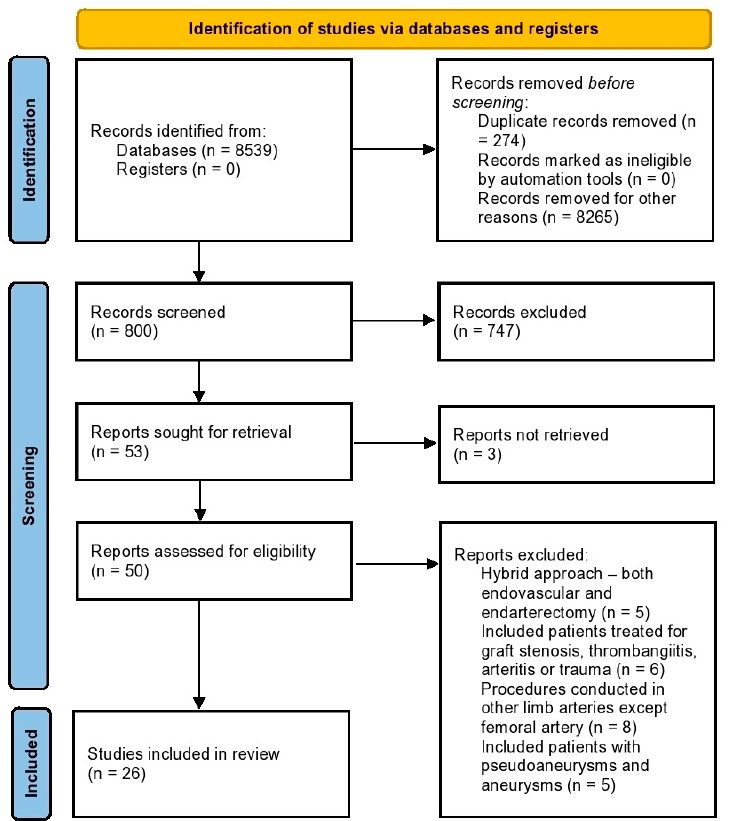
Figure 1. PRISMA flowchart (other reasons—review articles, studies describing the treatment of carotid/iliac/coronary arteries, and the use of hybrid techniques). Table 1. Summary of studies included and patient characteristics.